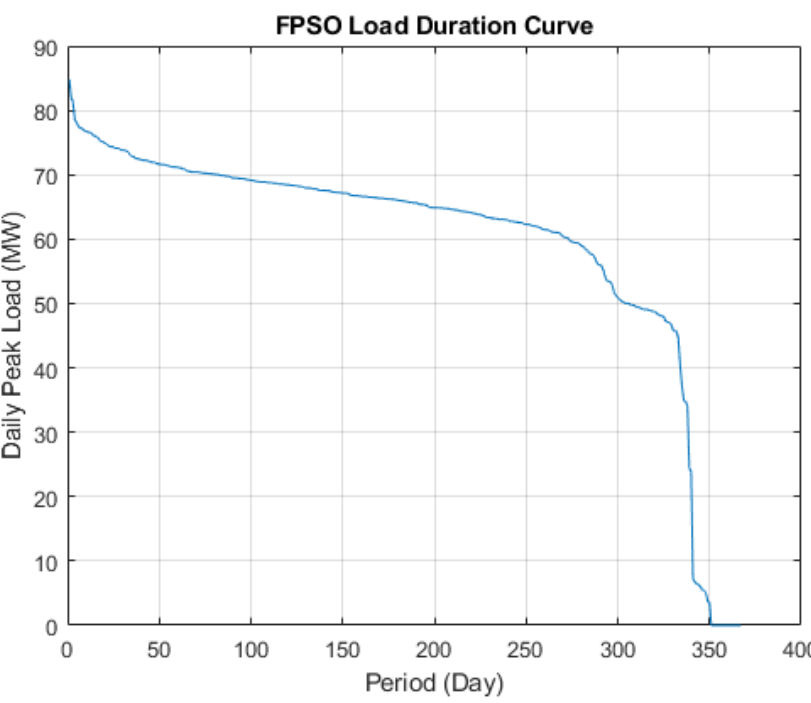
Figure 4. Floating production storage and offloading load duration